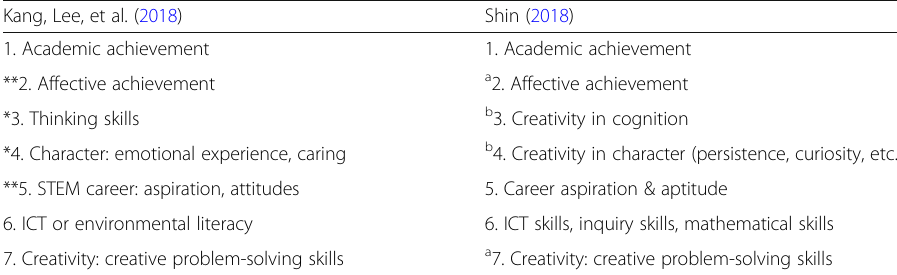
Table 3 Dependent variables in two studies Kang, Lee, et al.